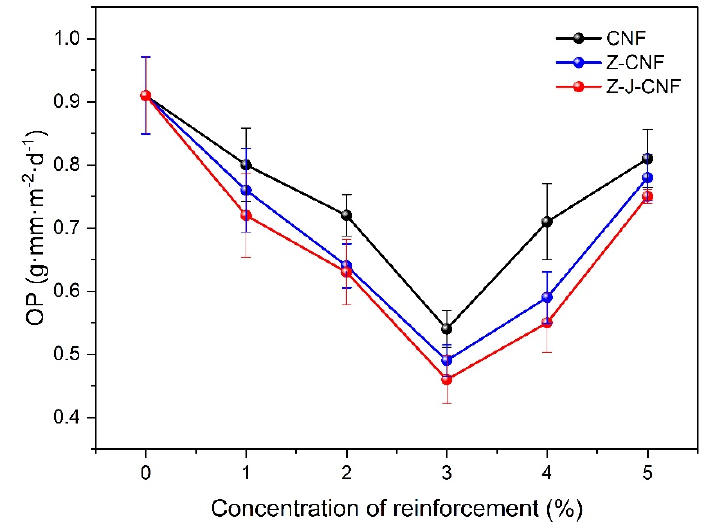
Figure 10. Effects of CNF, Z-CNF, and Z-J-CNF content on oil permeability (OP) of the films. Figure 10. E ff ects of CNF, Z-CNF, and Z-J-CNF content on oil permeability (OP) of the